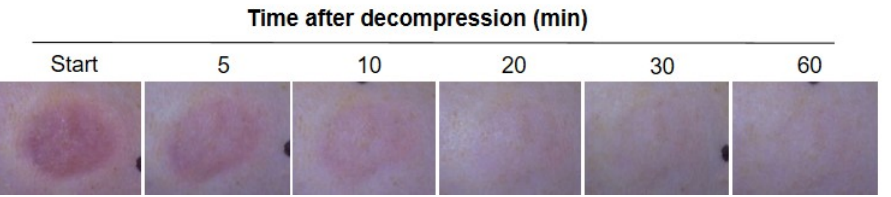
Figure 1. Representative macroscopic observation of blanchable erythema. The progress of ery- thema after decompression showed at the start and, 5, 10, 20, 30 and 60